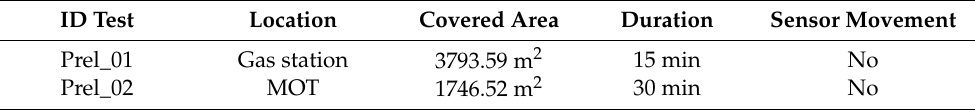
Table 2. Description of experiment setups.